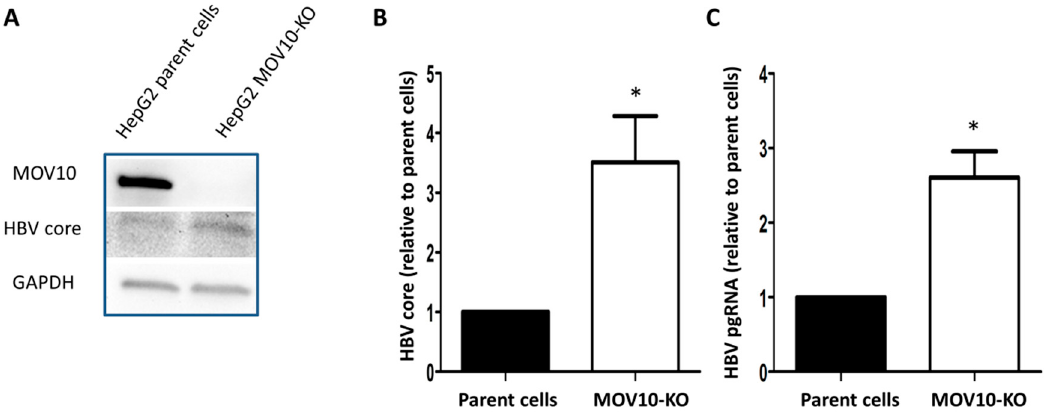
Figure 3. HBV gene expression in HepG2 MOV10-KO cells. ( A ) Western blot showing HBV core